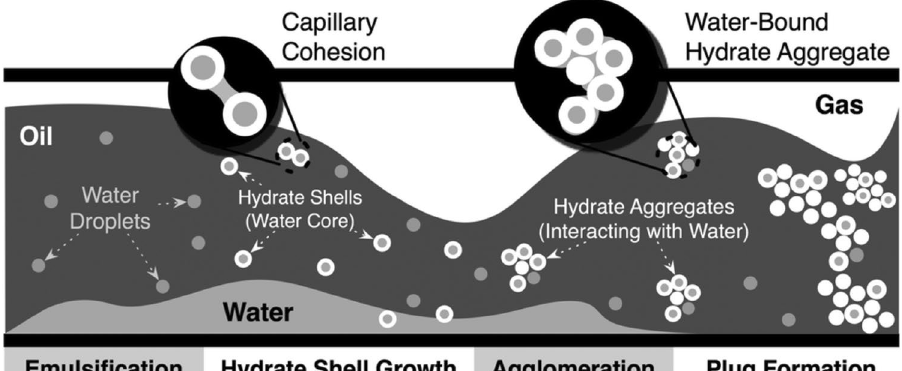
Fig. 1 Conceptual mechanism of hydrate blockage formation in pipelines during hydrocarbon transportation. Adapted from Turner et al. (2009) and